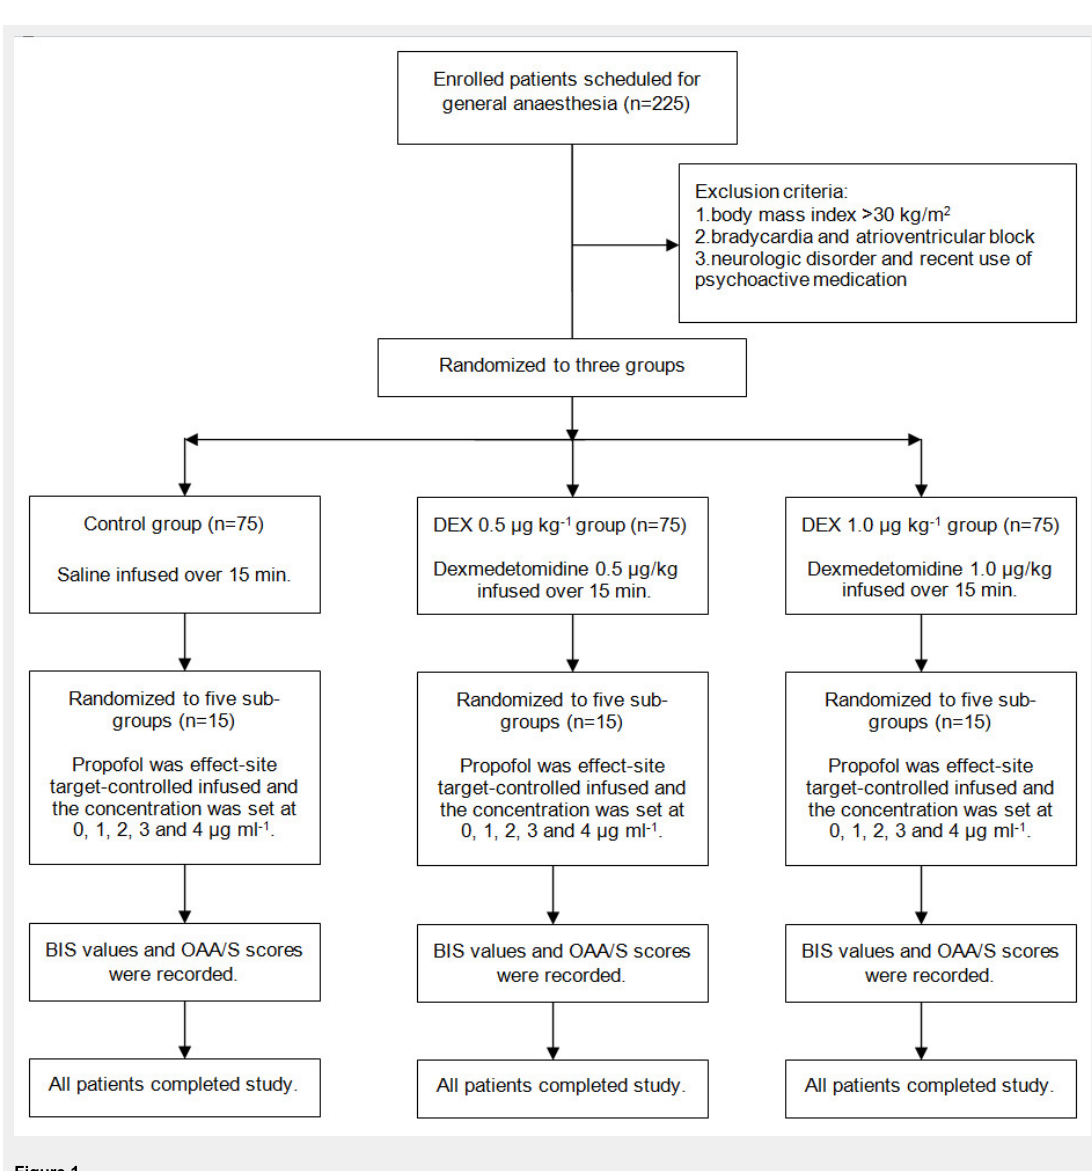
Figure 1 Disposition of the study